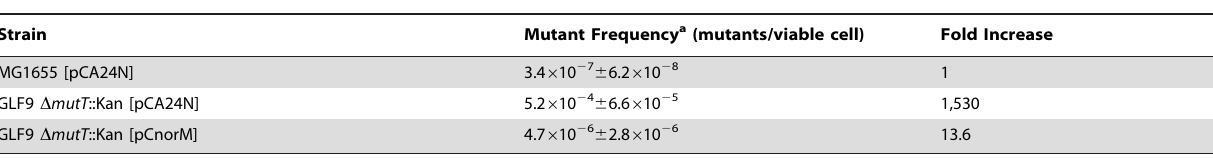
Table 3. Spontaneous Valine R mutant frequencies.